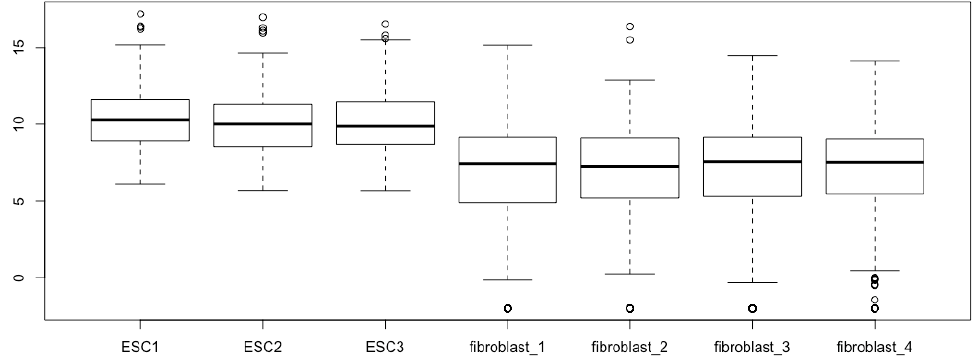
Figure 5. Re-order boxplots (compare it with Figure 4).